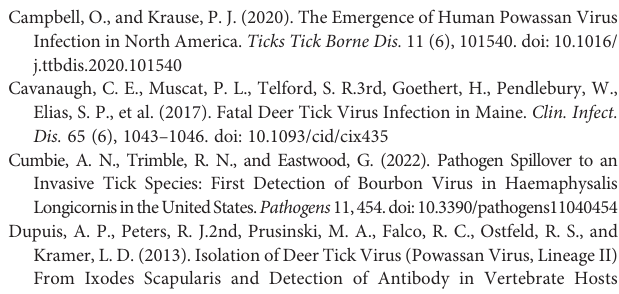
Supplementary Figure 1 | Clinical markers of POWV-disease progression in mice infested with media-injected H. longicornis . (A) Percent weight change is represented as a line plot relative to the weight at study day 0. (B) Clinical disease scores are represented as a line plot with higher cumulative scores representing more severe disease. Cumulative clinical scores were assigned to each mouse daily based on weight loss, appearance, neurological signs of disease, and behavior. Supplementary Figure 2 | Detection of POWV RNA in blood from mice used in tick acquisition feeding experiment. Mice were intraperitoneally injected with POWV II, infested with pathogen-free larval and nymphal H. longicornis , then bled at 1 and 3 days post-injection (d.p.i.). The viremia data are presented as means with standard errors of the means. Statistical signi fi cance was determined using a two-tailed unpaired t test, **P < 0.01. Limit of detection ~15 gene fragment copies per ng